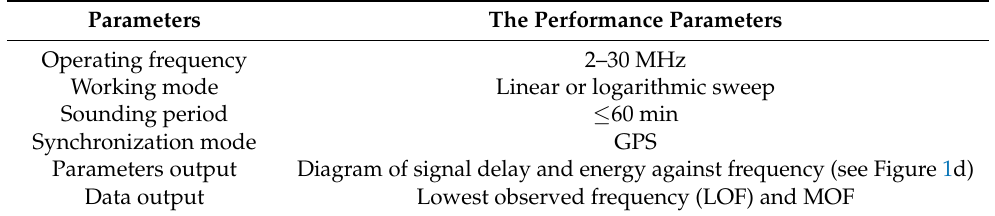
Table 3. The performance parameters of oblique sounding